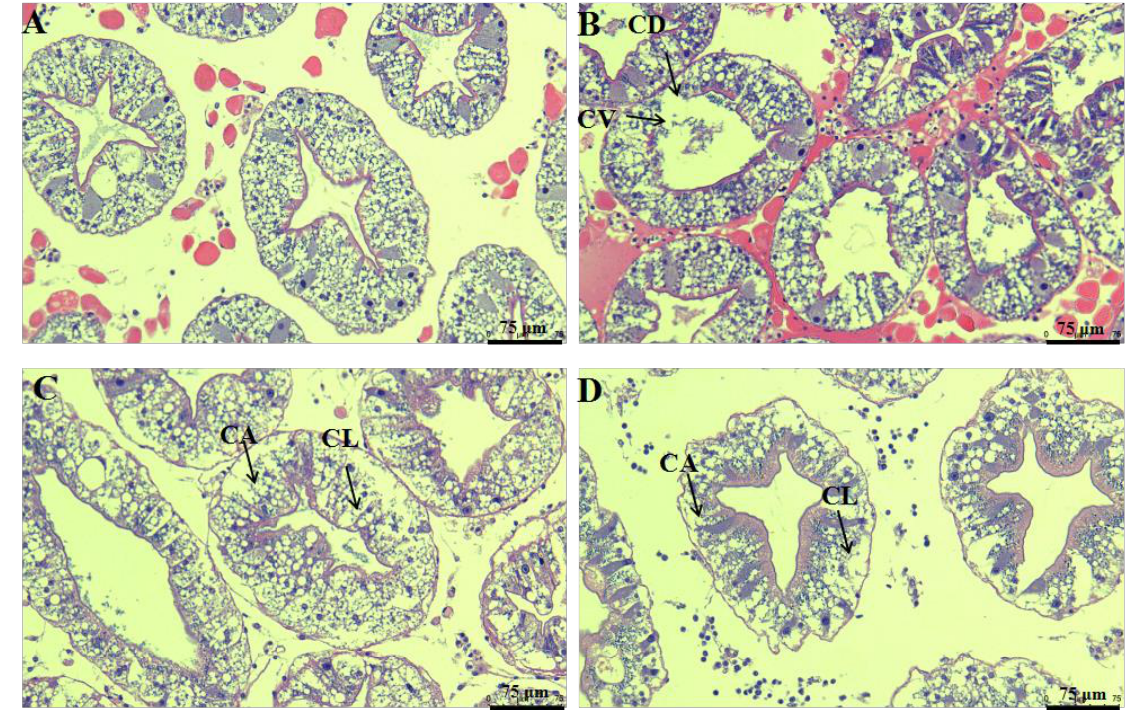
Figure 2. Histological changes after cadmium exposure: ( A ) control group; ( B ) 0.01 mg/L cadmium treatment group; ( C ) 0.05 mg/L cadmium treatment group; ( D ) 0.125 mg/L cadmium treatment group. Cell abscission (CA); Cytoplasmic vacuolization (CV); Cell border diffusion (CD); Cell lysis (CL).